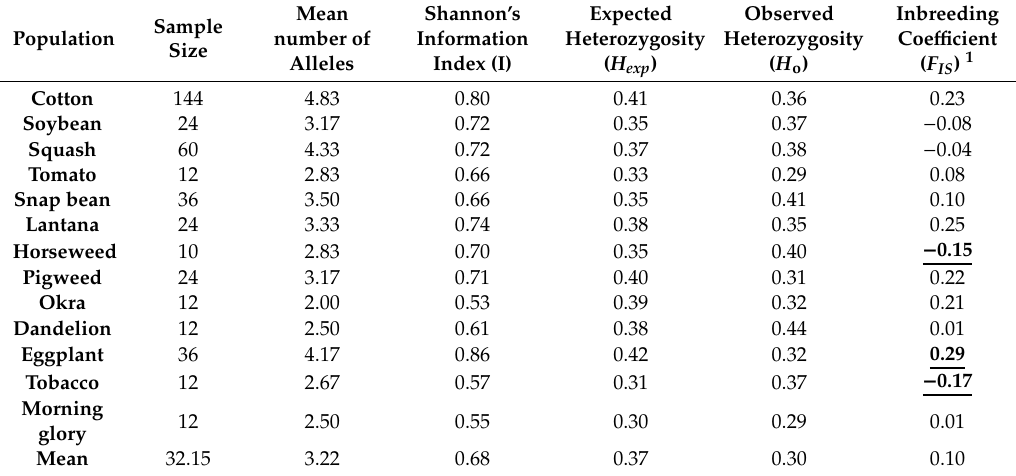
Table 3. Genetic diversity of B. tabaci MEAM1 populations collected from di ff erent plant species based on six microsatellites markers. Sample Population Size